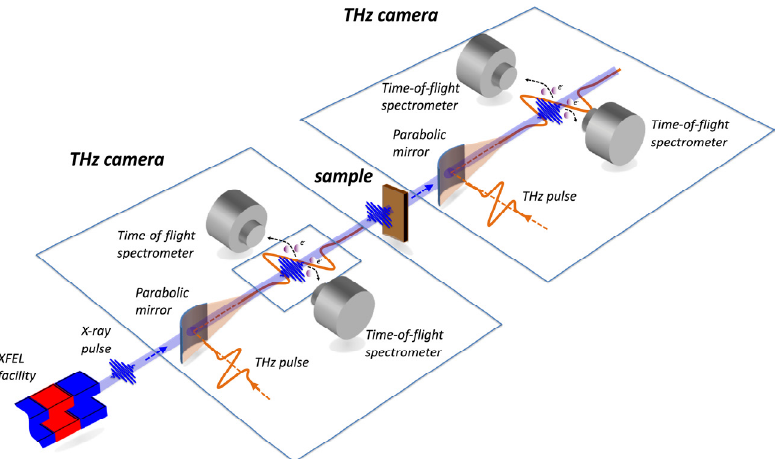
Figure 1. Schematic concept of X-ray chronoscopy experiment using two terahertz streaking spec- trometers. The first THz setup is used to determine time distribution of the incident pulse ( 𝐼 0 (cid:4666)𝑡(cid:4667) measurement), and the second one provides a measure of time distribution of X-ray pulse after in- teraction with the sample ( 𝐼 1 (cid:4666)𝑡(cid:4667) measurement). Both spectrometers work in shot-to-shot mode, giv- ing the possibility of either single-shot or cumulative measurement. The ratio of the measured time distribution curves will provide details on nonlinear processes induced by X-rays in the sample.